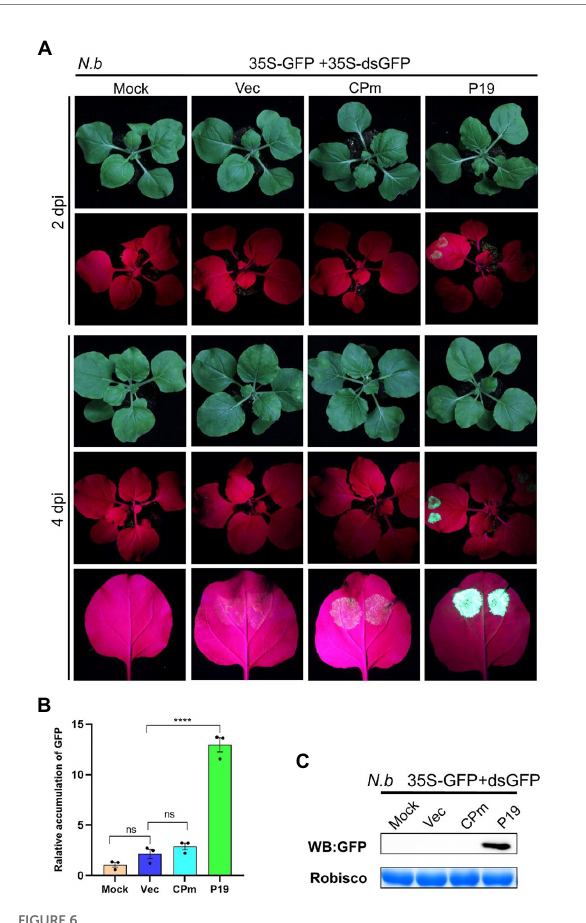
FIGURE 6 Tomato chlorosis viru s CPm not suppressing RNA silencing triggered by GFP dsRNA. (A) Photographs taken under the white and UV light of Nicotiana benthamiana leaves at 2 and 4 days postinfiltration (dpi) with A. tumefaciens harboring 35S-GFP and 35S GF-IR, either in combination with the pBIN19-3HA empty vector (Vec), or with constructs expressing CPm or P19 . (B) Relative mRNA levels of GFP were measured by RT-qPCR. (C) Western blotting analysis of GFP protein extracted from the zones infiltrated with Agrobacterium tumefaciens harboring the constructs indicated above each lane at 4